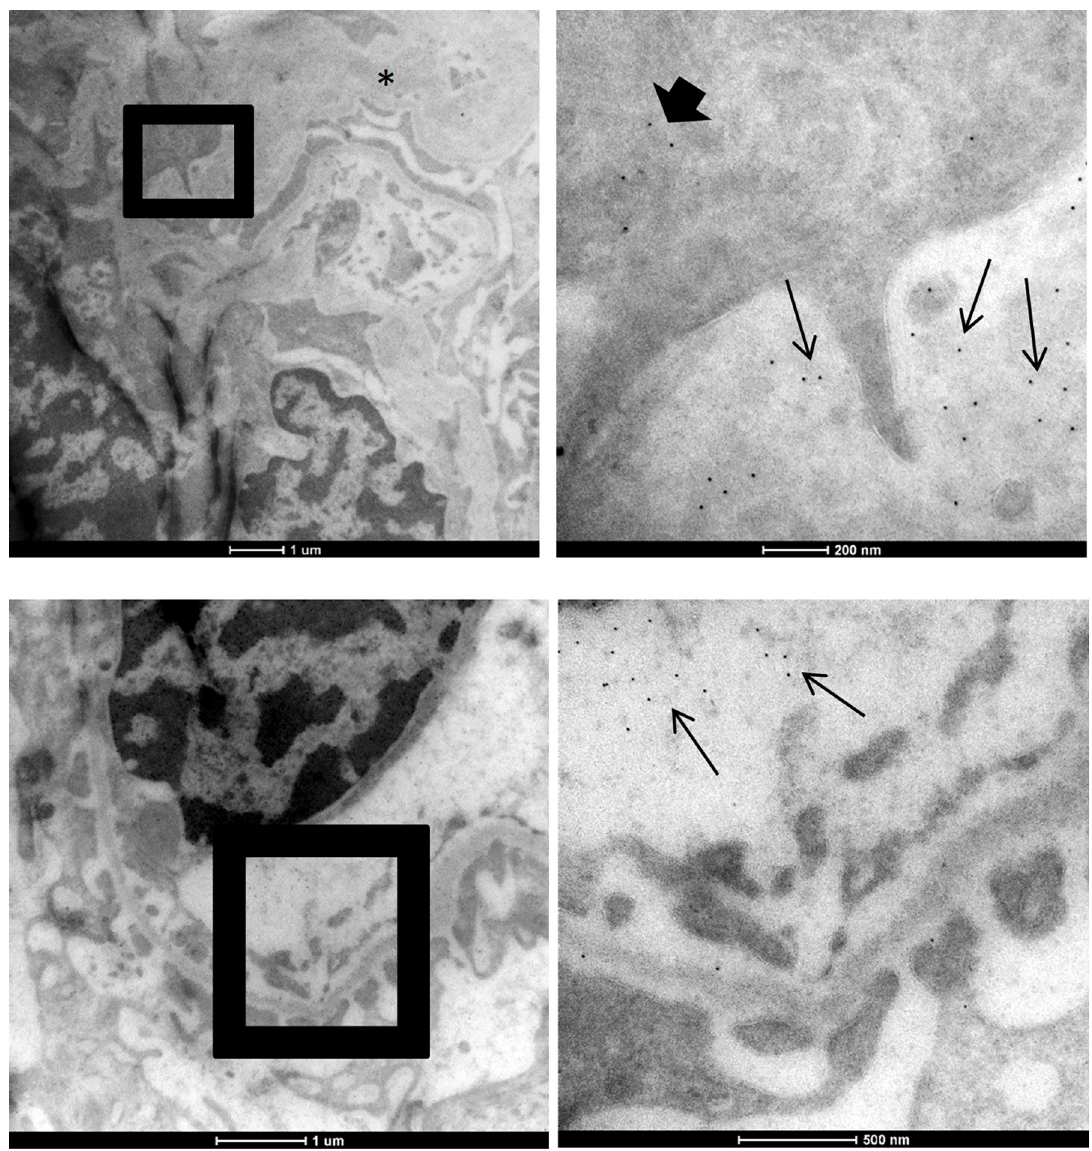
Fig 4. EM images of anti-histone H3 immunolabelling after 4 hours of warm ischemia in severely damaged glomerular cells. Histone H3 was detected by immuno-EM using antibody labelling with 10 nm gold particles (visible as small black dots). Top row: representative images are shown for histone H3 localization surrounding a podocyte with foot process effacement (asterisk, left image), with histones in the cytoplasm (thick arrow and in extracellular debris (thin arrows) in a “bug shot pattern”, right image). Bottom row: extracellular histone H3 is released from an endothelial cell with loss of endothelial fenestrations and subendothelial accumulation of electronlucent material (left image enlarged area in right image) with histone localisation in extracellular debris (thin arrows, right image). Scale bar represents 1 μ m or 200 nm or 500 nm as